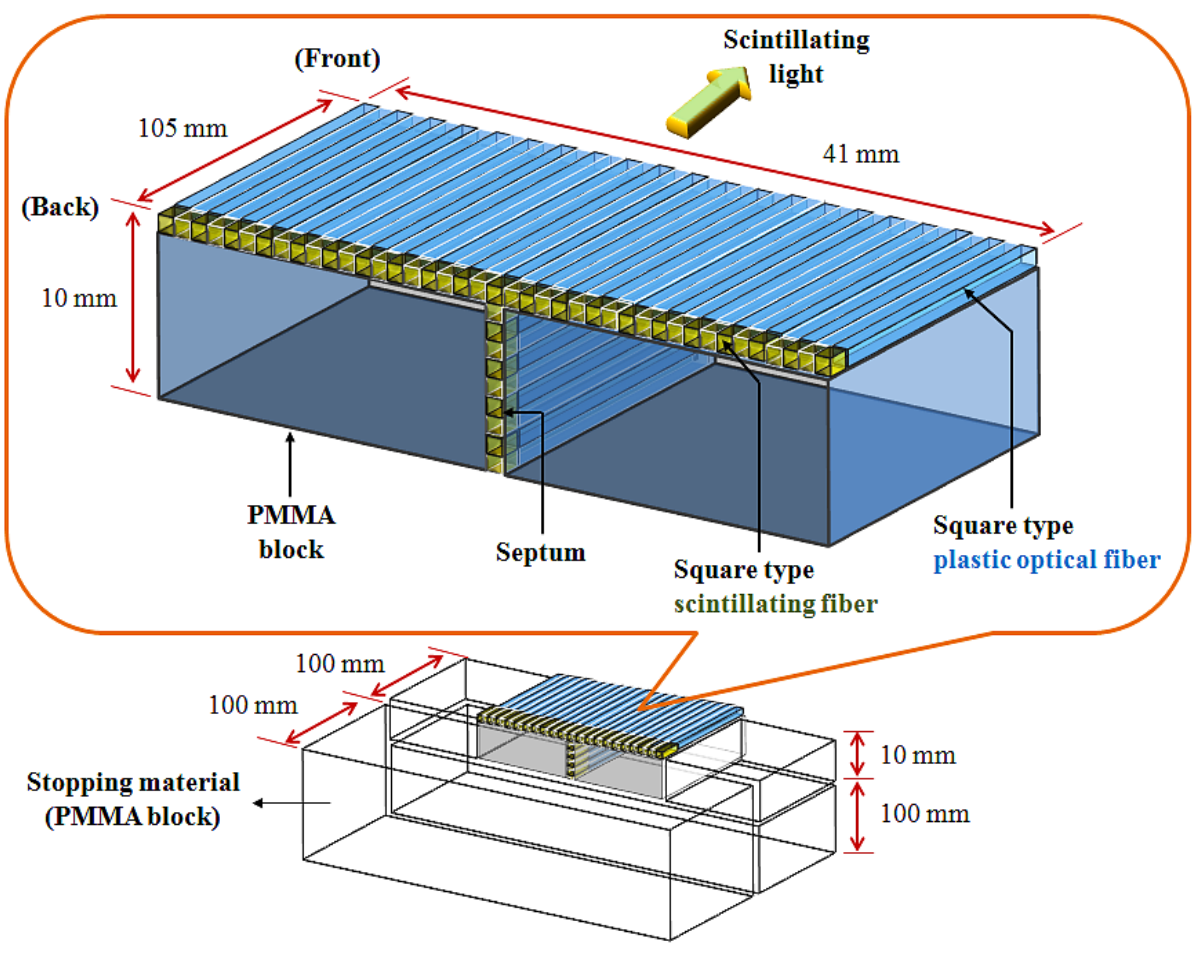
Figure 1. Structure of the fiber-optic